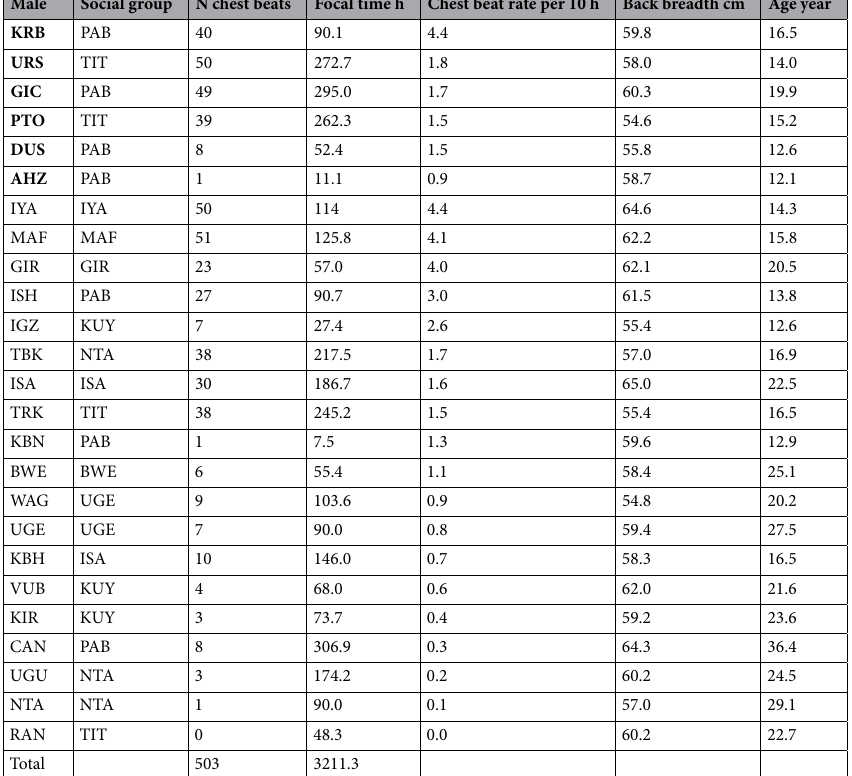
Table 1. Chest beats recorded during focal animal follows, together with back breadth and age of the mountain gorilla males (males in acoustic analysis are shown in bold). Data for the number of chest beats were collected during focal animal follows to enable the calculation of a rate of chest beating. Due to the logistical difficulties of recording chest beats, we collected the acoustic recordings of chest beats at different times. Age is the mean age during the study period.